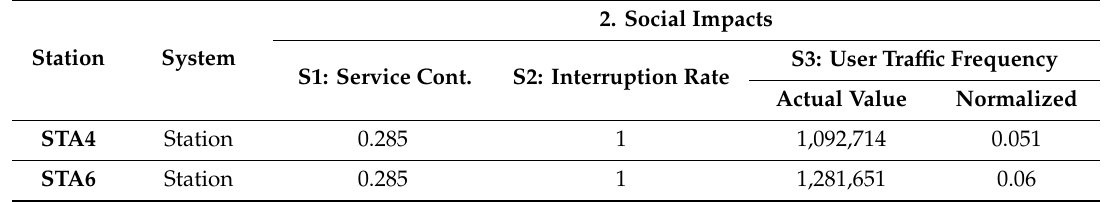
Table 6. Social Impacts Scores.